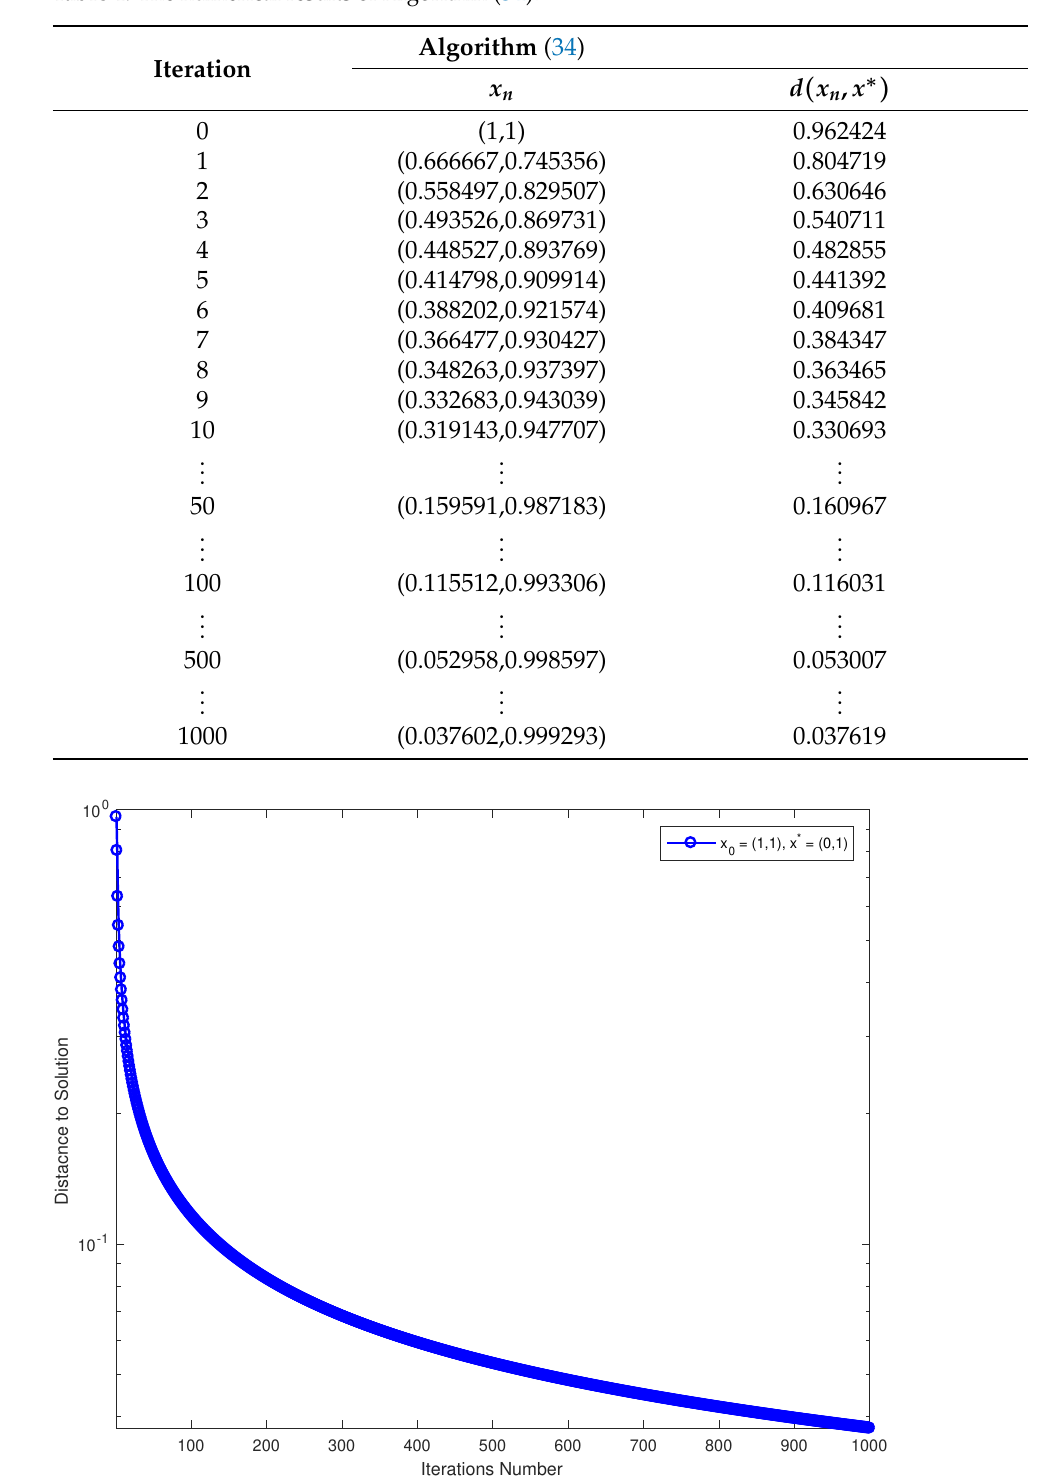
Table 4. The numerical results of Algorithm (34) .